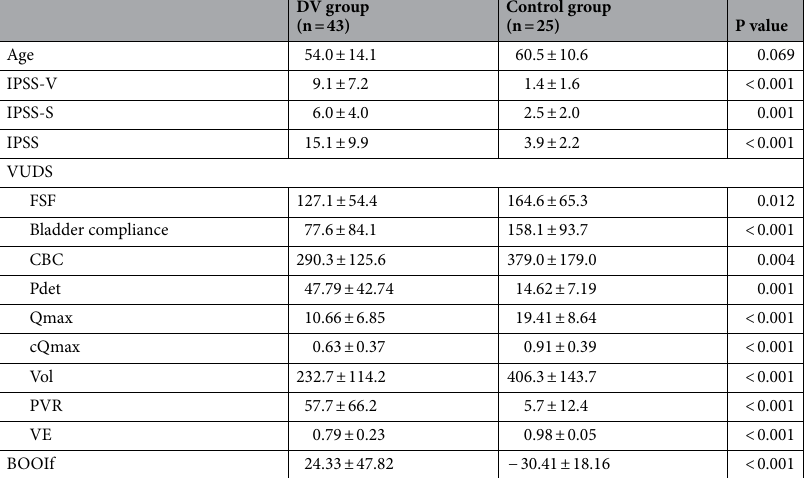
Table 1. Clinical characteristics of patients with DV and controls. DV Dysfunctional voiding, IPSS International prostate symptom score, IPSS‑S International prostate symptom score storage subscore, IPSS‑V